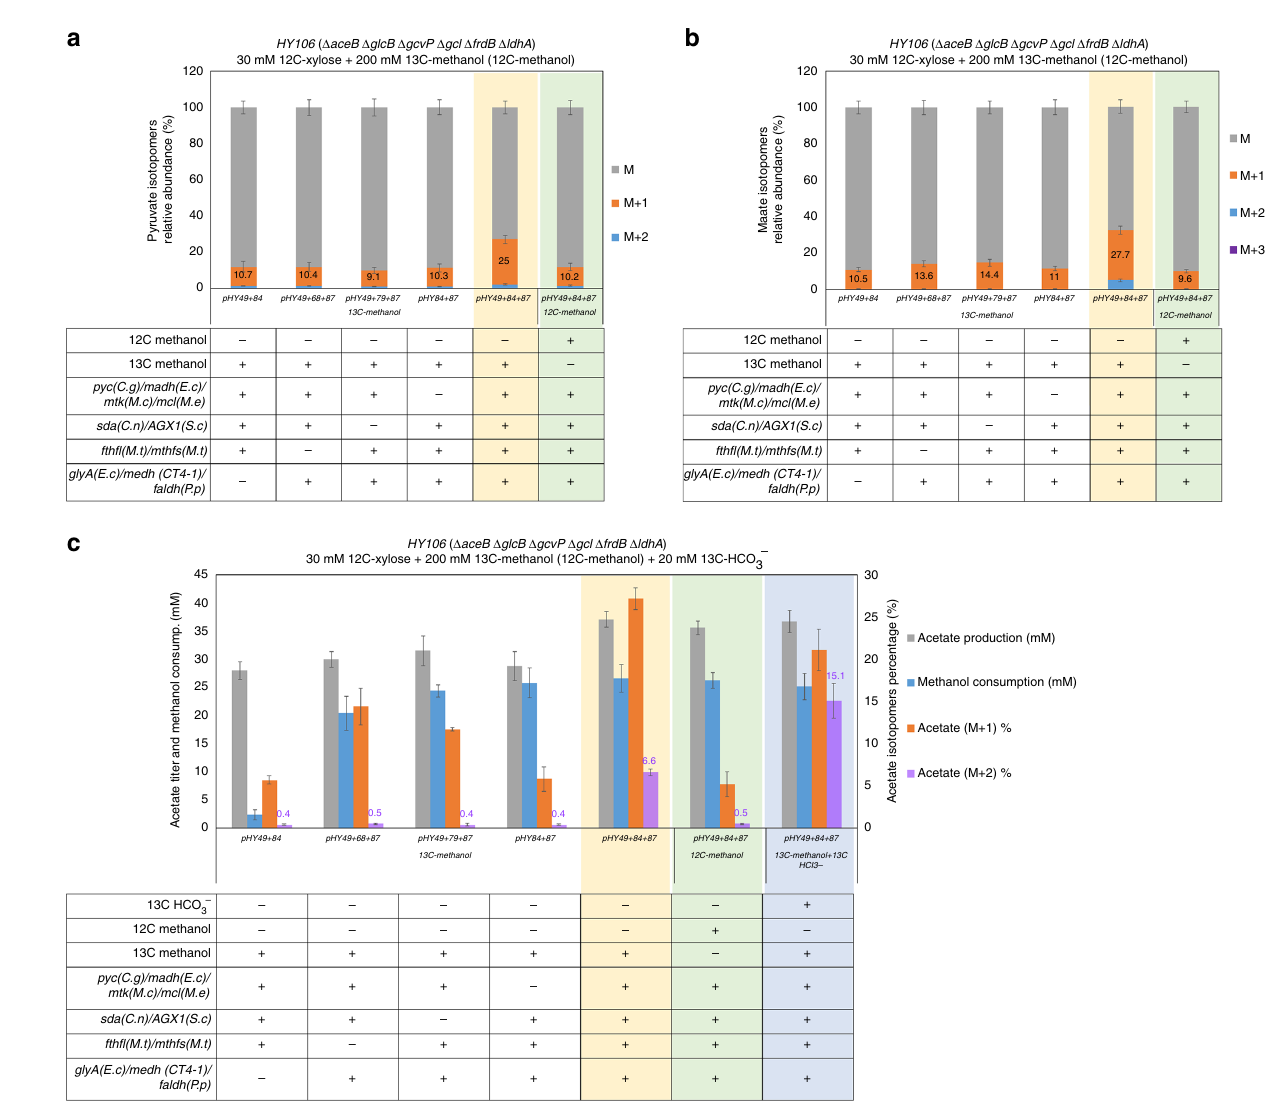
Fig. 4 Analysis of the labeling pattern of intracellular metabolites and extracellular acetate produced by the strain HY106 with expressing different groups of the cycle genes. a , b Relative abundance of mass isotopomers for intracellular pyruvate ( a ) and malate ( b ) in the engineered strains with expressing different groups of cycle genes. The strains were incubated in minimal medium with supplements of 30 mM xylose and 200 mM 13C-methnaol (or unlabeled methanol) for 3 h. c Expression of the modi fi ed serine cycle allowed the E. coli strain to assimilate methanol and bicarbonate into acetate. The strains were incubated in minimal medium with supplements of 30 mM xylose, 200 mM 13C-methnaol, and 20 mM 13C-HCO 3 − for 20 h. Xylose (30 mM) was consumed after 20 h. Error bars are s.d., n =